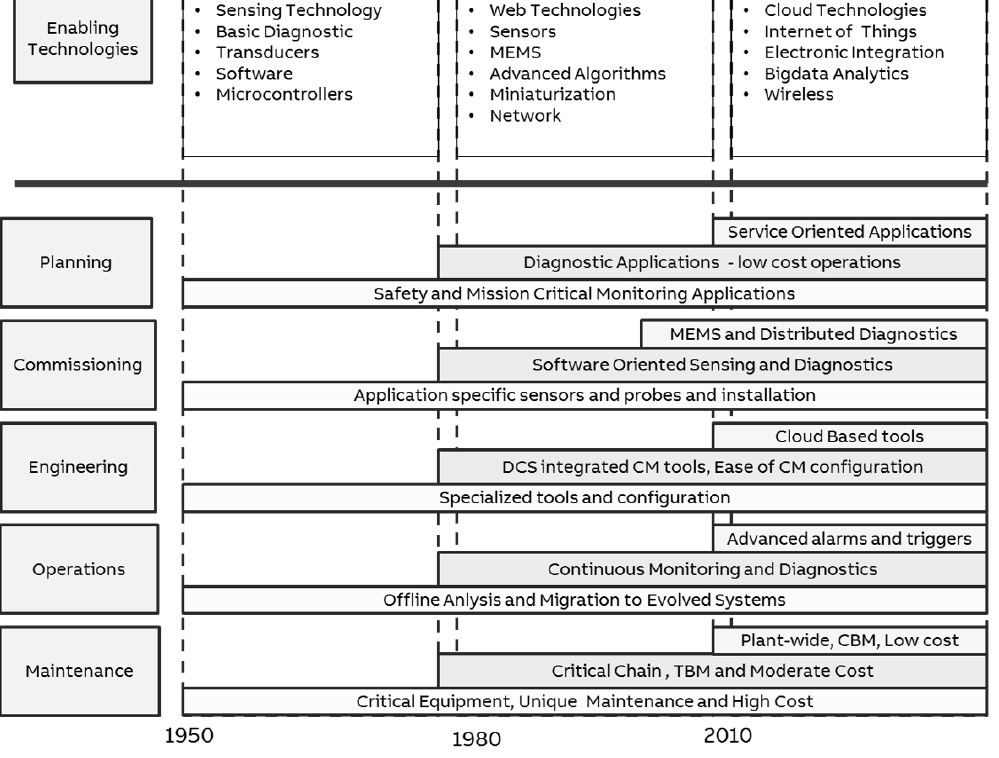
Figure 1. Technology trends, plant life cycle and monitoring system